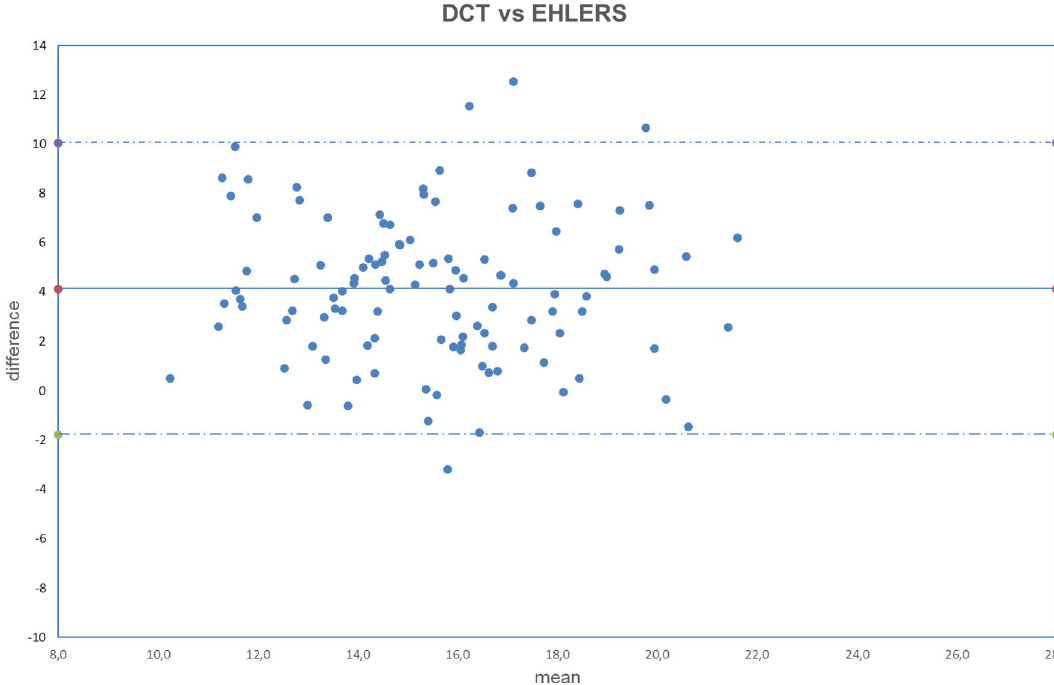
Figure 9. Bland–Altman plot between IOP measured with DCT and GAT corrected with Ehlers formula. Dashed line: mean difference. Dash-dotted lines: mean difference (4.13 mmHg) ± 2 standard deviation (2.95 mmHg) of the differences.